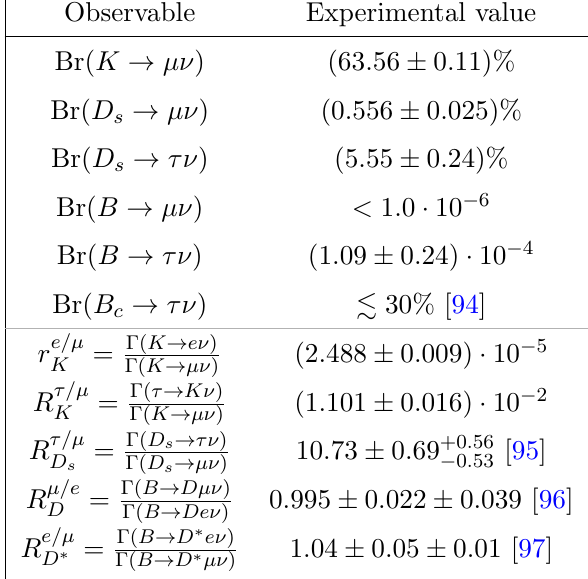
Table 3. A table summarizing the experimental values we take for the various leptonic branching ratios and LFU ratios considered in this section. Measurements quoted without explicit citation are taken from ref.